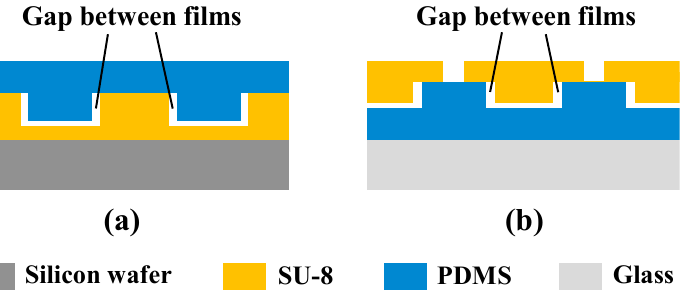
Figure 3. Schematic diagram of shrinkage phenomenon in molding process: ( a ) PDMS shrinkage; ( b ) shrinkage of SU-8 photoresist. Table 1. Dimension changes during molding process.